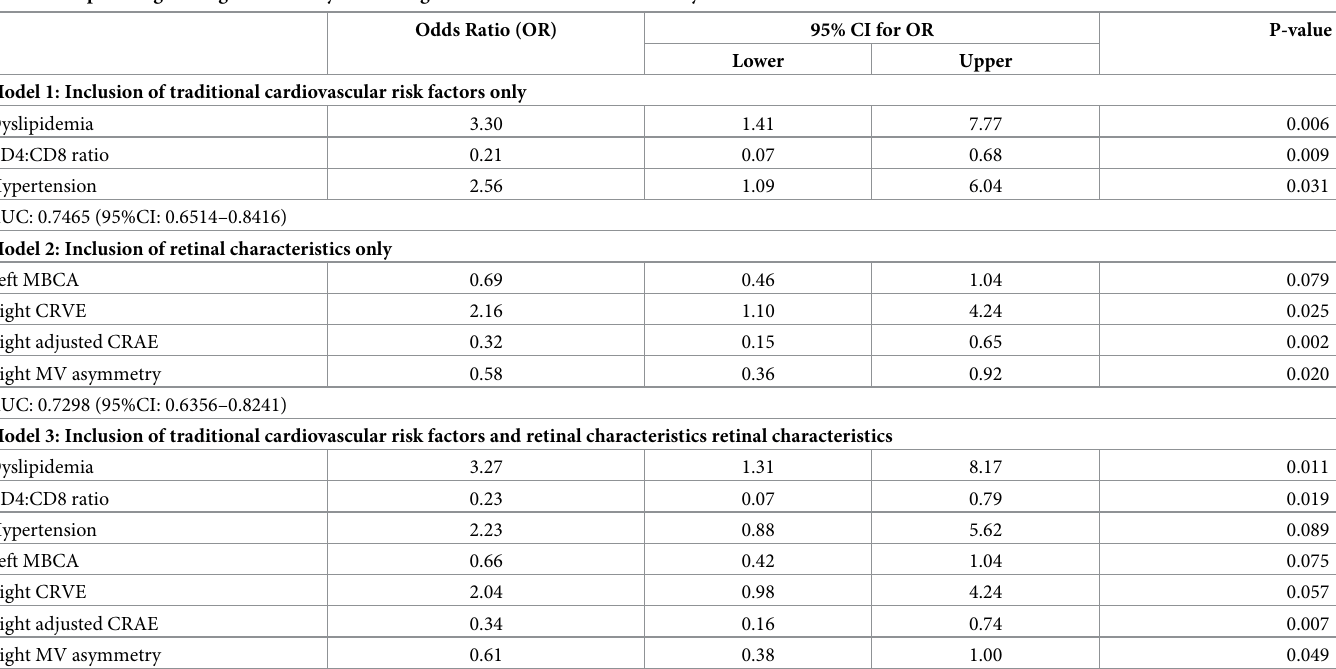
Table 3. Stepwise logistic regression analysis showing factors associated with coronary atherosclerosis in different models. Odds Ratio (OR) 95% CI for